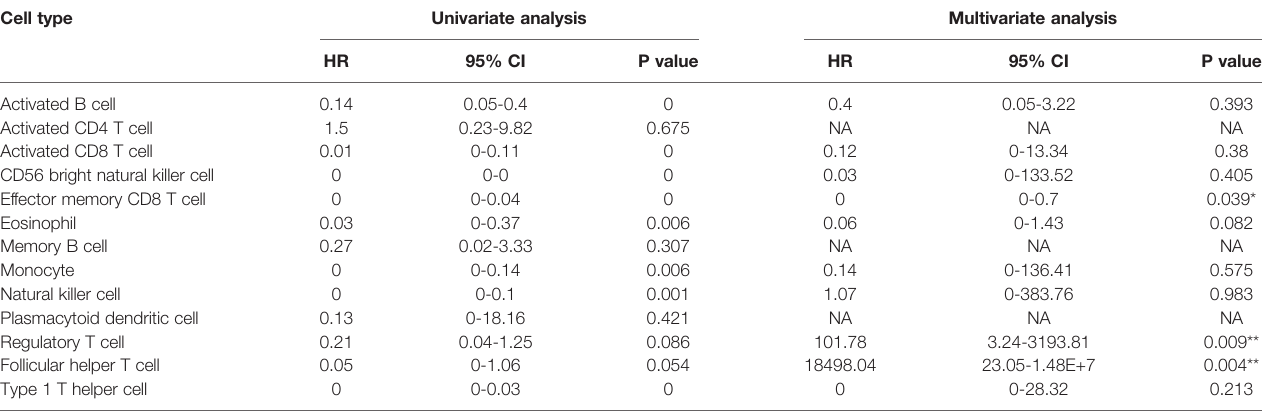
TABLE 1 | Univariate and multivariate Cox regression analyses of the thirteen immune cell types. Cell